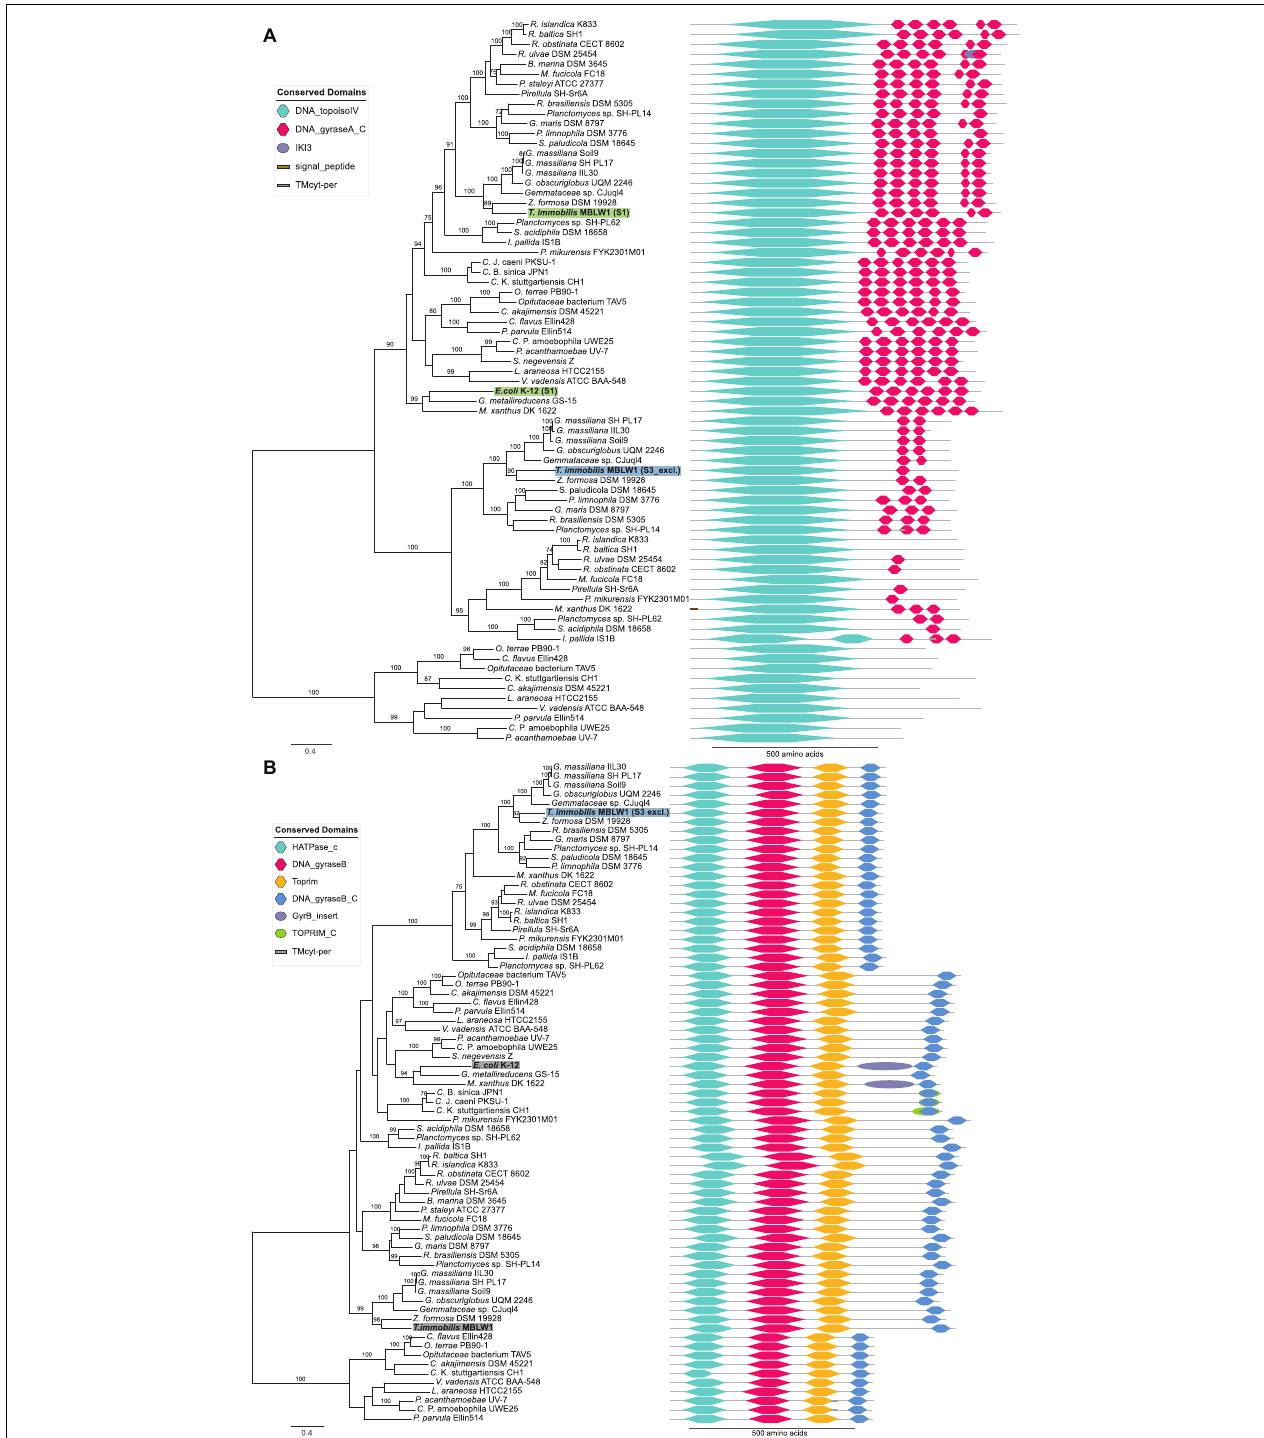
FIGURE 14 | Phylogeny and domain architecture of (A) GyrA and (B) GyrB in Planctomycetes and other bacteria. The species names of the proteins expressed in the subcellular fractionation assay are shown in bold. The corresponding fractions are mentioned in parenthesis and further highlighted by colored boxes [green: Tris (S1), blue: SDS (S3)]. Gray boxes highlight expressed proteins without a clear fractionation profile. Signal peptides and transmembrane domains were annotated using SignalP-5.0b and Phobius 1.01. Conserved domains were assigned to the proteins using the pfam_scan.pl script with a minimum sequence-evalue of 0.01 and the Pfam 32.0 database. The proteins were aligned using the mafft-linsi alignment algorithm in MAFFT v7.310, and a maximum likelihood phylogeny was inferred using LG + (cid:48) amino acid substitution model with 100 bootstraps in RAxML version 8.0.26. Bootstrap values below 70 are not shown.